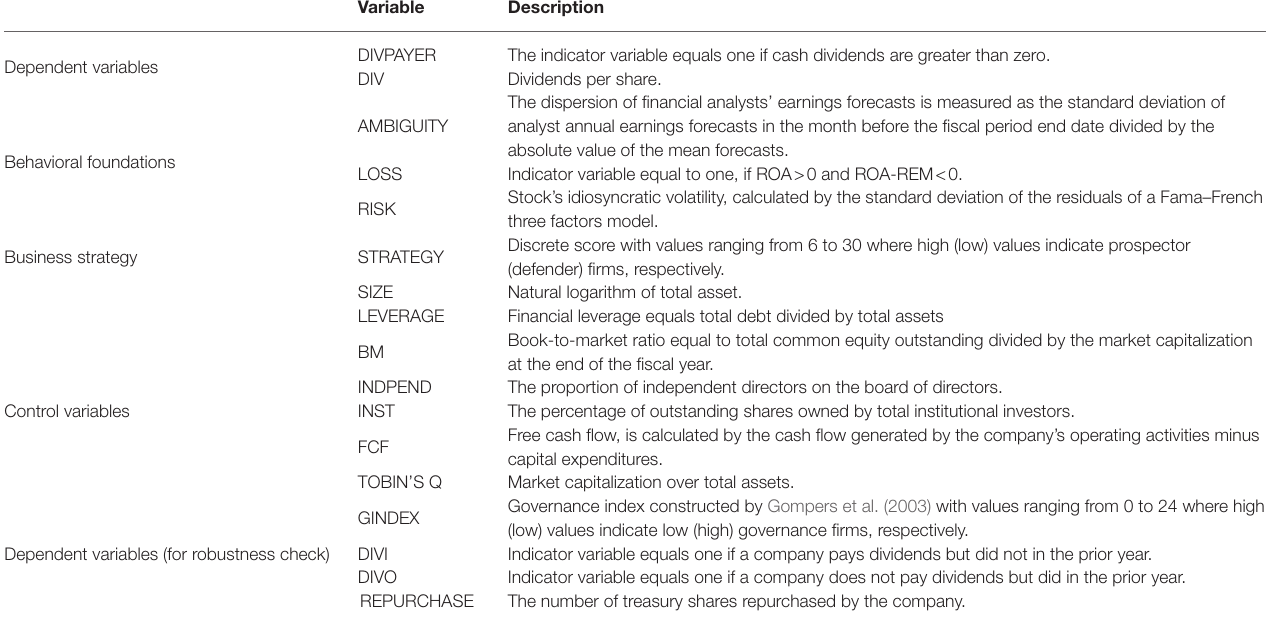
Variable Description